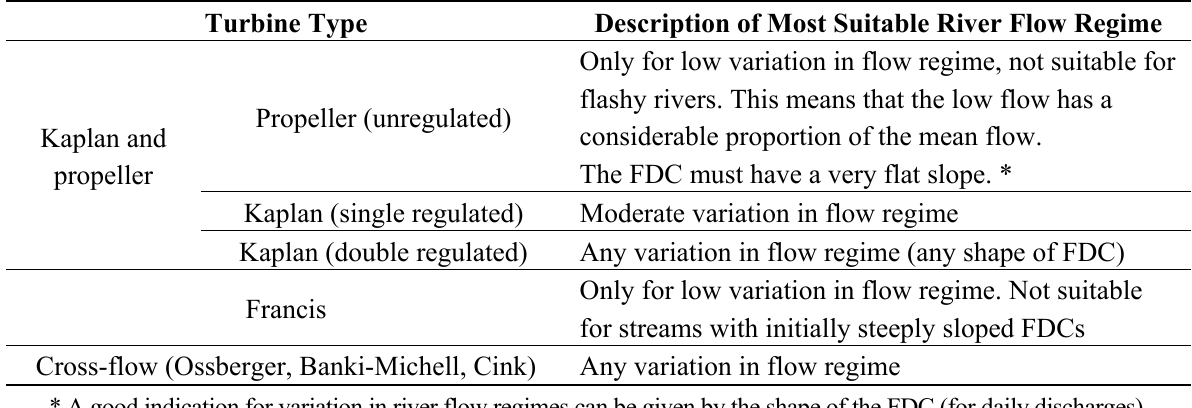
Table 7. Recommended turbine type taking into account river flow